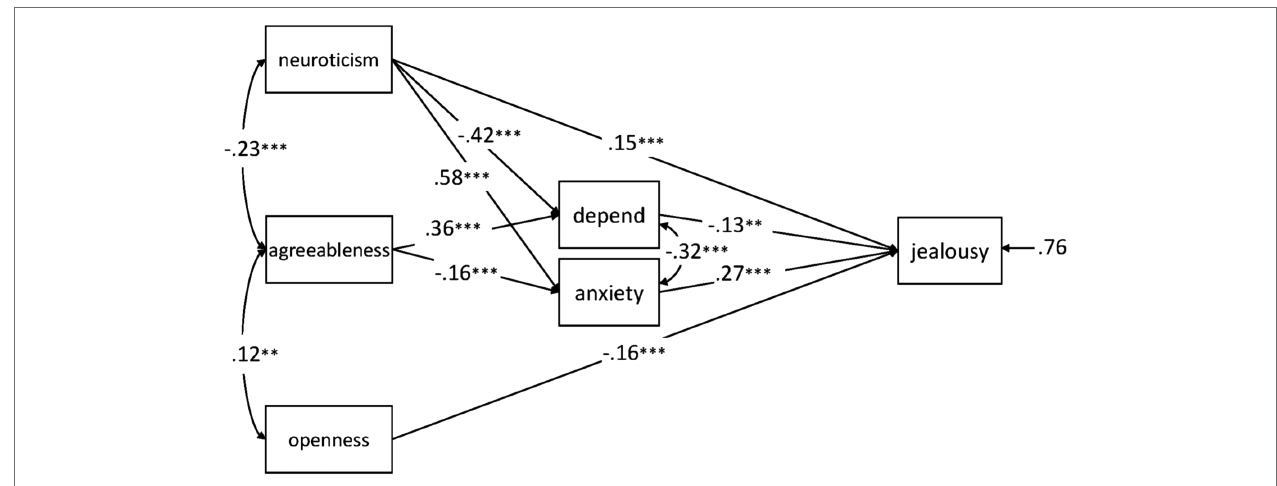
FIGURE 1 | Path analysis with standardized estimates for the relationships between the adult attachment subscales depend and anxiety , neuroticism, agreeableness, openness, and jealousy in the total sample ( N = 847). ** p < 0.01; *** p <